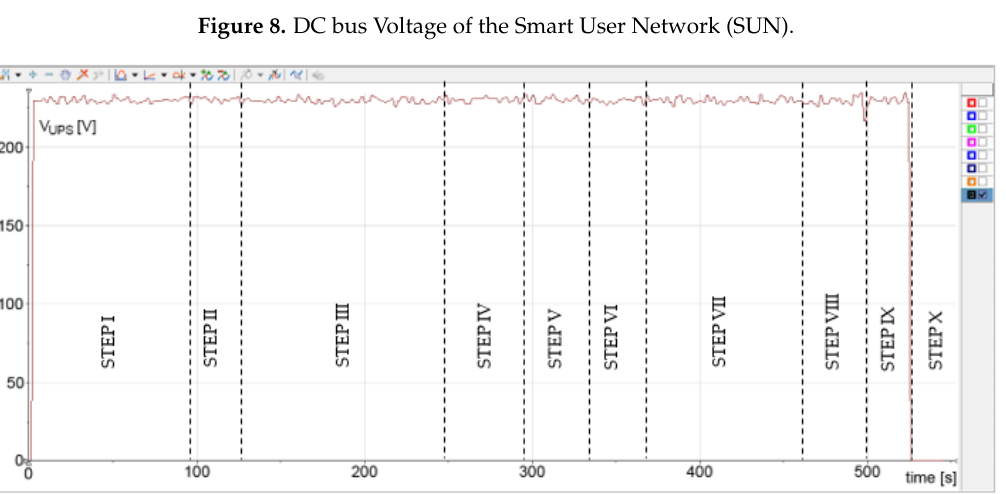
Figure 9. Root Mean Square (RMS) AC voltage of the bidirectional DC/AC converter (Conv3) to supply the critical loads.